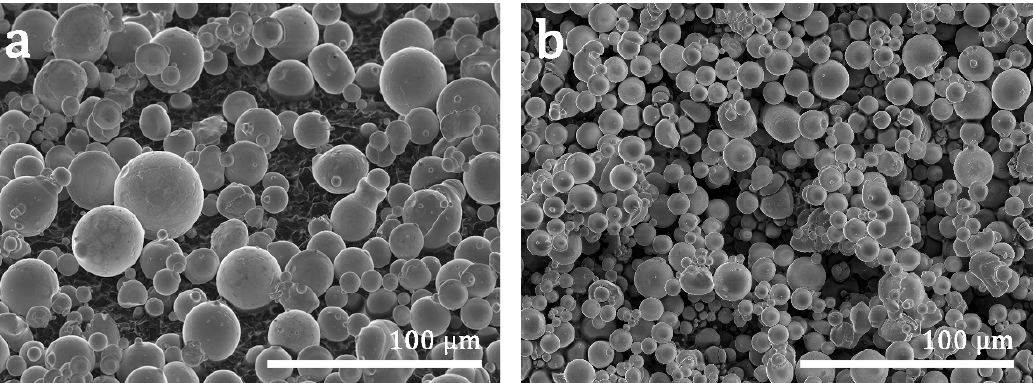
Figure 2. ( a , b ) SEM–SE images of the SMA powder showing different sizes of particles with a diameter below 63 µ m. ( a ) Medium size particles 20–45 µ m; ( b ) Small size particles 0–20 µ m.